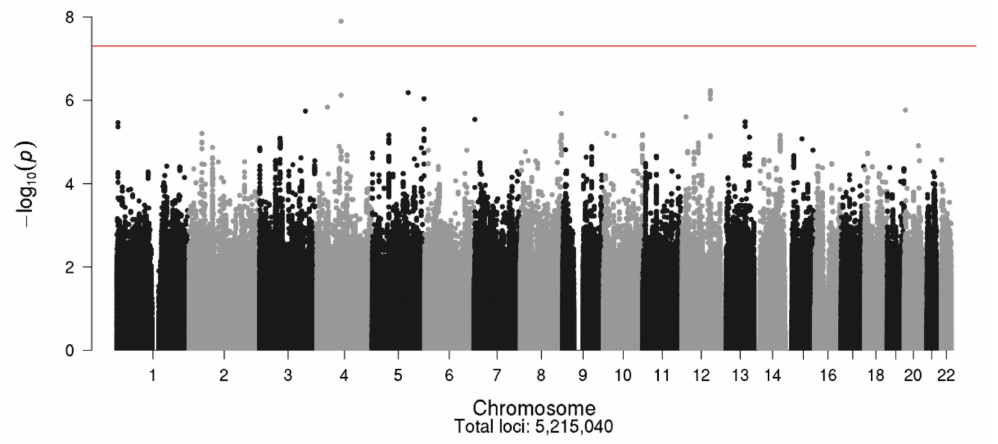
Figure 4. Manhattan plot for the MCBDR study.